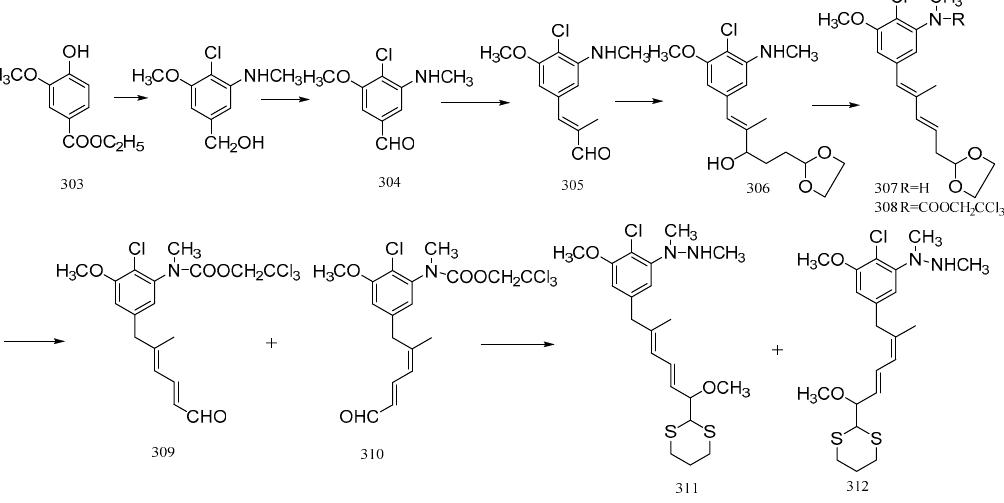
Figure 19. Compounds synthesized from the ( S )-(+)-4-hydroxy-2-cyclopentenone derivative of maytansine.